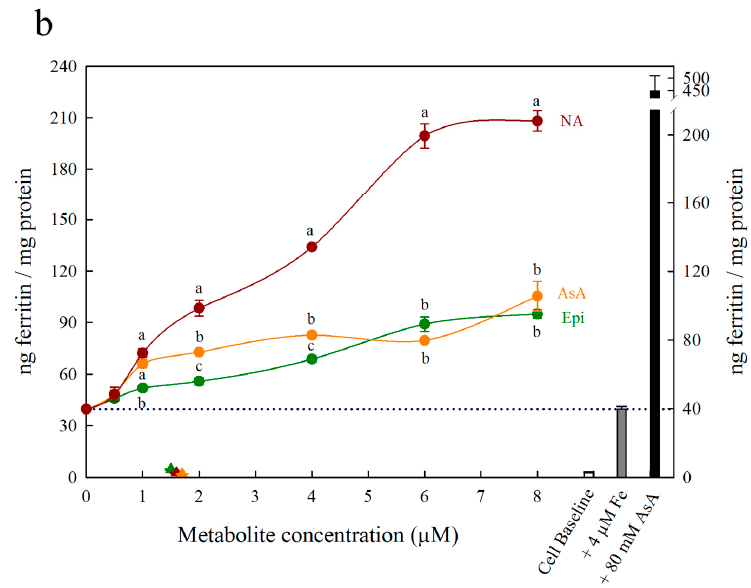
Figure 3. Ferritin formation in Caco-2 cells in response to nicotianamine (NA, red), ascorbic acid (AsA, orange) and epicatechin (Epi, green) at concentrations varying between ( a ) 0–2.0 μ M and ( b ) 0–8 μ M in solution with Fe (4 μ M). Triangles indicate ferritin formation in metabolite solutions (1.6 μ M) without Fe. Dotted line indicates ferritin response to 4 μ M Fe alone and is extended to both y axes to facilitate comparison with other treatments. Error bars represent standard error of the mean of three replicates. Different letters indicate significantly different ferritin formation between metabolites of the same concentration as analyzed by one-way ANOVA with Tukey post-hoc test ( p < 0.05).